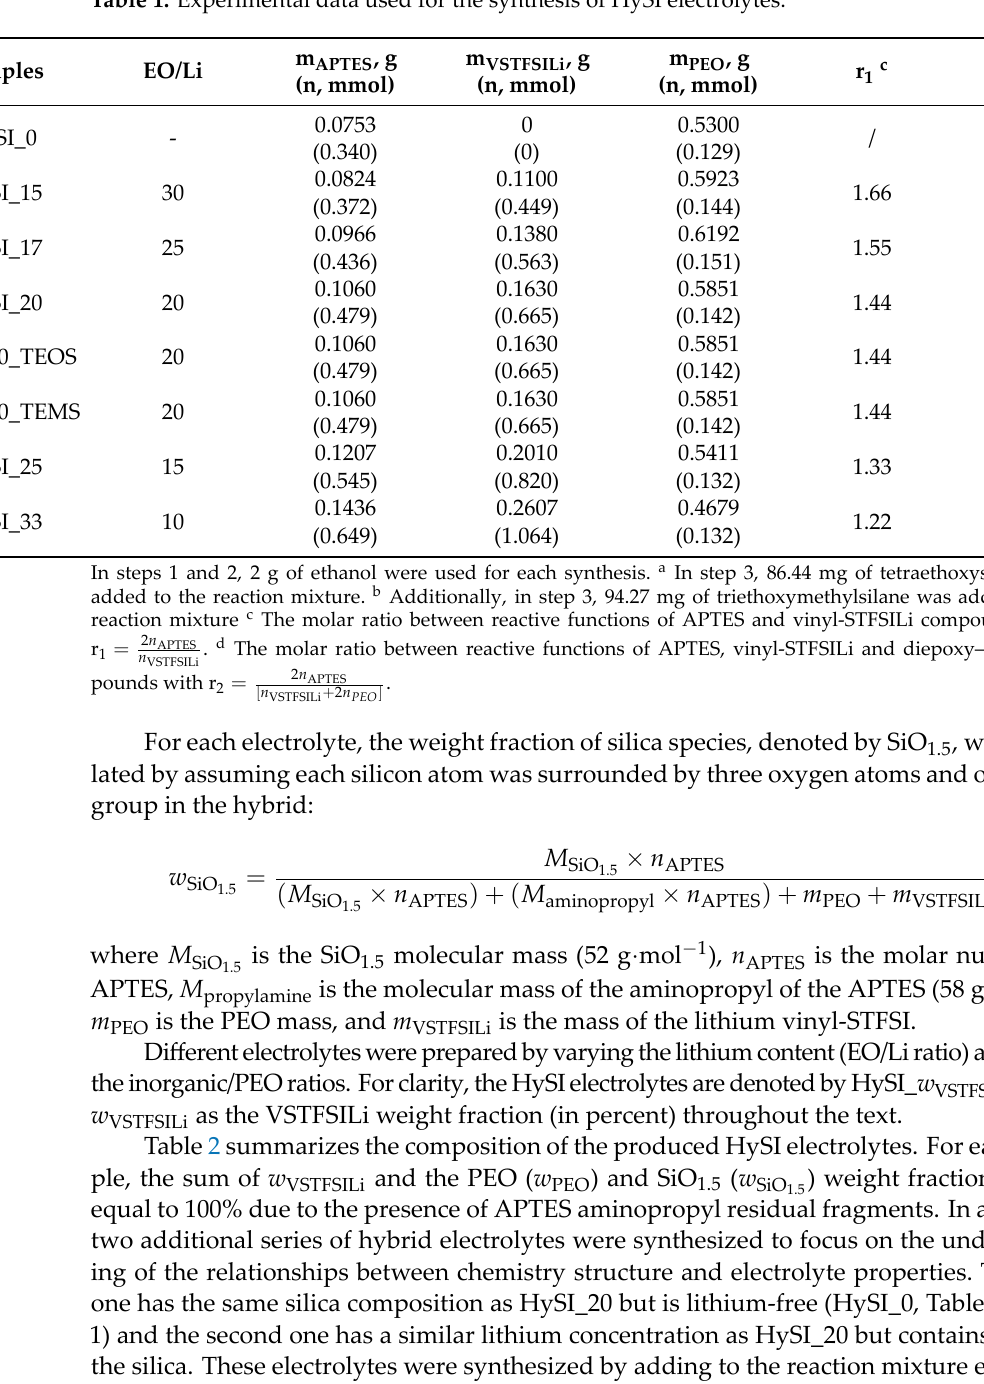
Table 1. Experimental data used for the synthesis of HySI